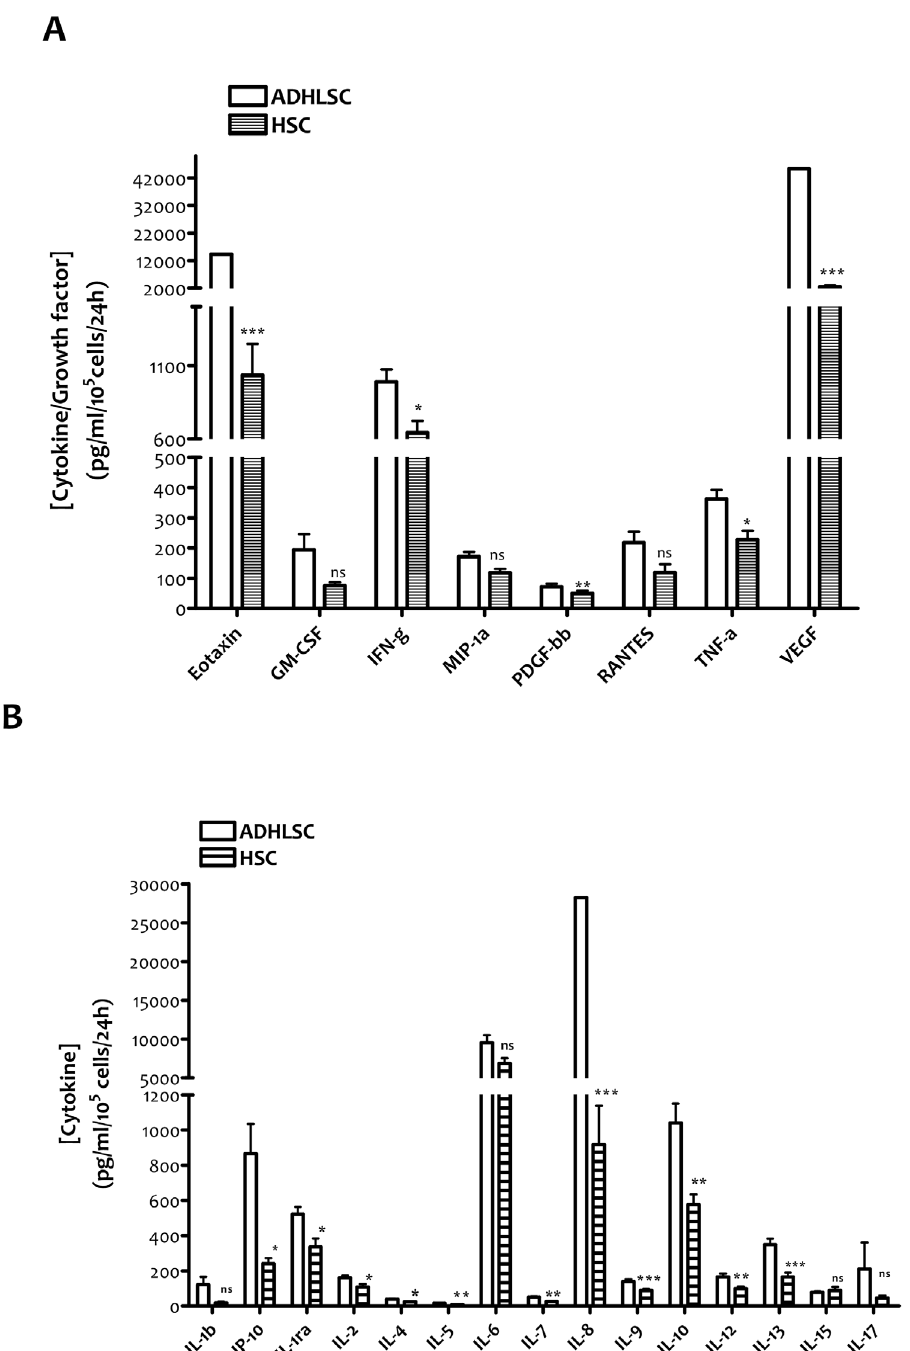
Figure 5. Secretome analysis of ADHLSC and HSC using a multiplex technology (Luminex). The analyses were performed on culture supernatants collected 24 hours after incubation with serum free medium (n=3, from 2 healthy and 1 diseased donors; analyzed at passage 5 and passage 7). The growth factors and cytokines concentrations were calculated for 100 000 cells. A , ADHLSC secrete high levels of VEGF, PDGFbb and Eotaxin as compared to HSC. *** denotes a p value , 0,001; ** denotes a p value , 0,01; * denotes a p value , 0,05. NS: Not significant. B , concerning pro-inflammatory cytokines, ADHLSC highly secreted IP-10 (3.6 times), IL-5 (2 times), IL-7 (2 times), IL-8 (30 times), and IL-17 (4.5 times) as compared to HSC. With respect to anti-inflammatory cytokines, ADHLSC significantly secreted higher level of IL-13 (2.1 times) and IL-10 (1.8 times). *** denotes a p value , 0,001; ** denotes a p value , 0,01; * denotes a p value , 0,05. NS: Not significant. doi:10.1371/journal.pone.0086137.g005 and TNF a and of some anti-inflammatory cytokines like IL-1ra, focused on cytokines implicated in the immune response and demonstrated that ADHLSC secreted greater amounts of pro- IL-4, IL-10 and IL-13. All these cytokines are secreted by adipose- inflammatory cytokines like IL-7, IL-8, IL-9, IL-12, interferon c derived MSC, stem cells possessing interesting immuno-modula-